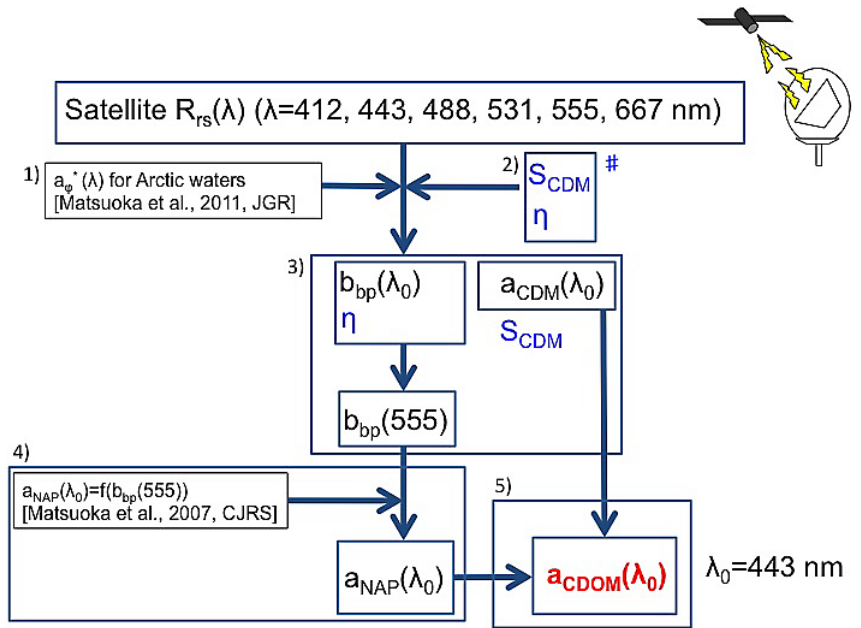
Fig. 2. A flow-chart of our semi-analytical algorithm for estimating CDOM absorption. A “#” represents parameters which can be set either to be constant or as a function of R rs (λ) , depending on water class. These classes are determined using cluster analysis (Sect. 3.2). The coefficients used in the relationship a ∗ ϕ (λ) = A(λ) (chl) − B(λ) and the empirical relationship between a NAP (443) and b bp (555) used in our CDOM algorithm are summarized in Table